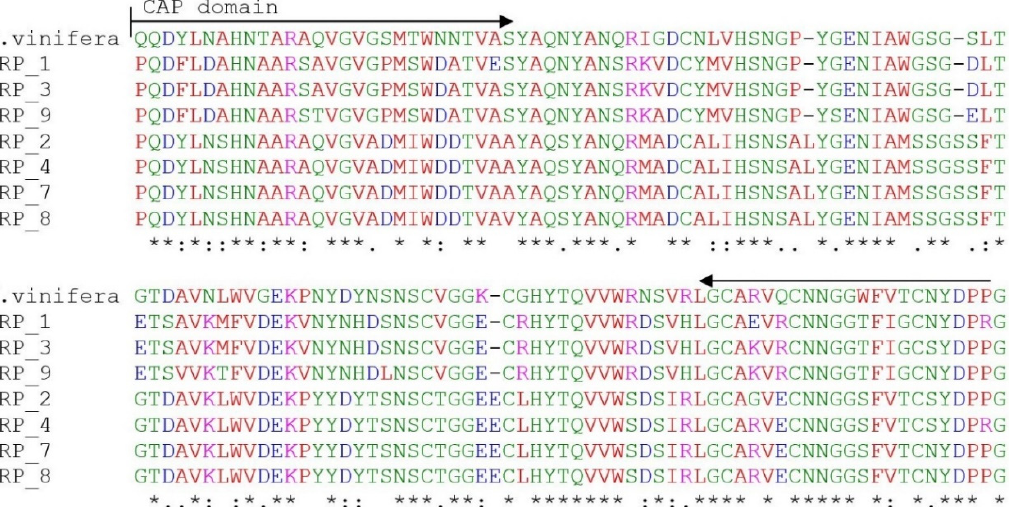
Figure 3. A multiple alignment of seven R. nigrum isolates and part of PR1 gene of V. vinifera (whole PR1 is 160 amino acids, according to the accession number XP_002273416.1). The underlined